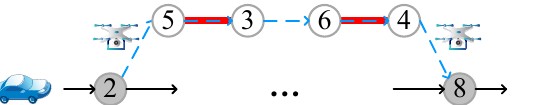
Figure 2. An example of a drone flight, where the numbers represent different nodes of the road network.